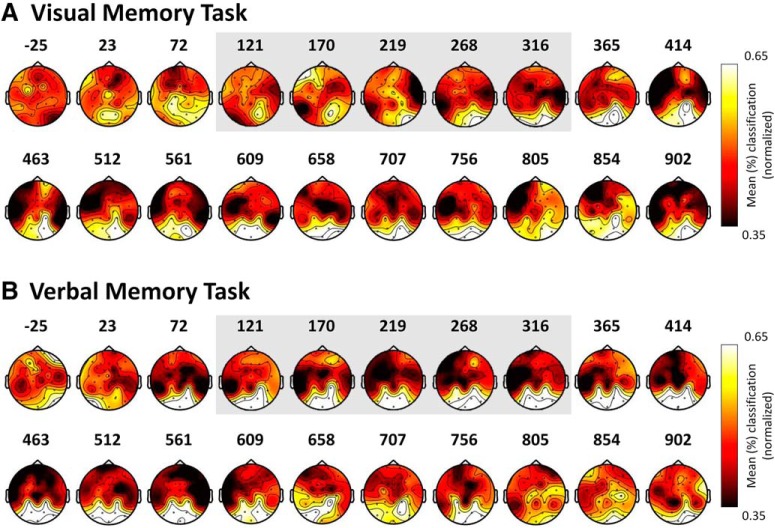
Contribution of each channel to the performance accuracy of the 20 pattern classifiers during the encoding phase of the visual and the verbal memory task. The gray frame highlights the time bins for which classification accuracy was highest.